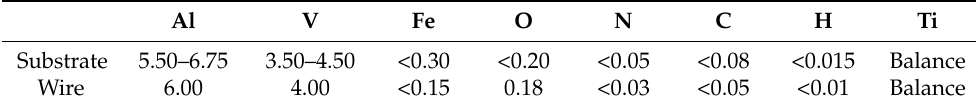
Table 1. Nominal chemical composition of the used material in weight %, comparable to